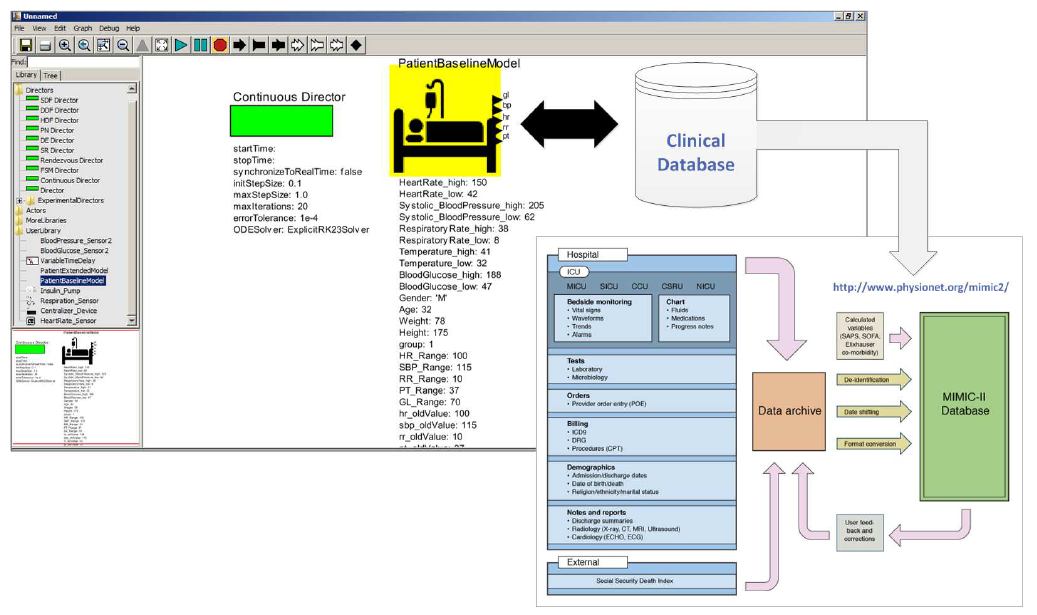
Figure 15. Selecting a Patient Model in the Ptolemy